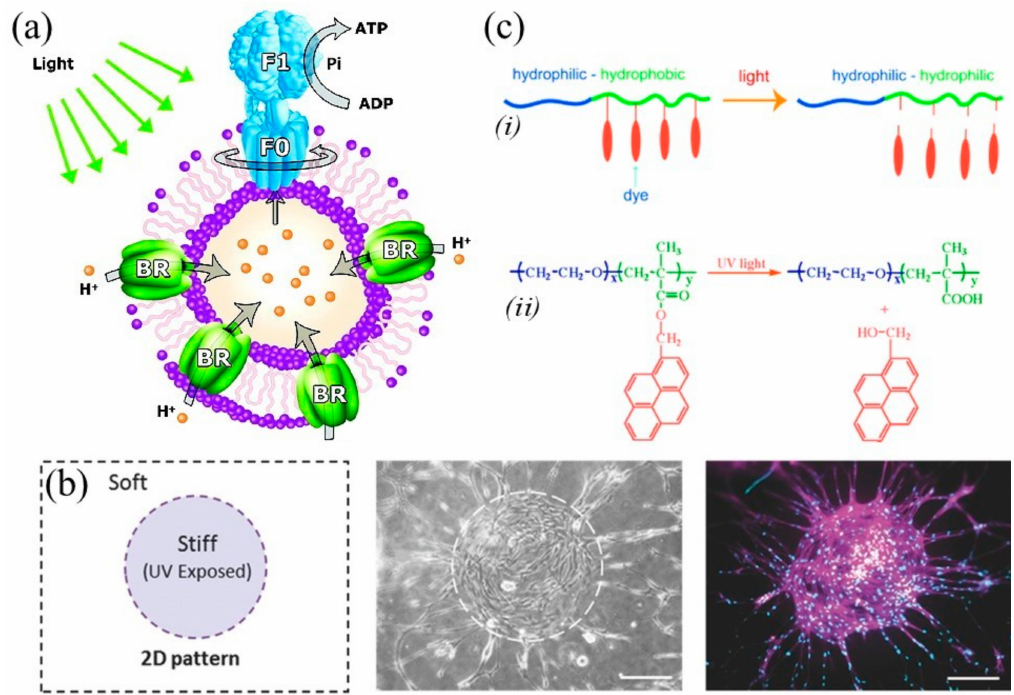
Figure 7. Photoresponsive materials: ( a ) Schematic representation of proteopolymersomes reconstituted with both BR and F0F1-ATP synthase. ATP synthase uses an electrochemical proton gradient generated by BR to synthesize ATP from ADP and inorganic phosphate. Reprinted with permission [138] © 2020 American Chemical Society. ( b ) 2D pattern with circular exposed spot: cells’ preferential adhesion, spreading, and proliferation are visible on the UV-exposed area after 4 d of culture. Reprinted with permission [130] © 2020 John Wiley and Sons. ( c ) Schematic illustration of light e ff ect: ( i ) detachment of dye pendant groups resulting in the hydrophobic-to-hydrophilic switch and ( ii ) chemical structure of the pyrene-containing amphiphilic diblock copolymer and its photosolvolysis under UV light irradiation. Reprinted with permission [136] © 2020 American Chemical